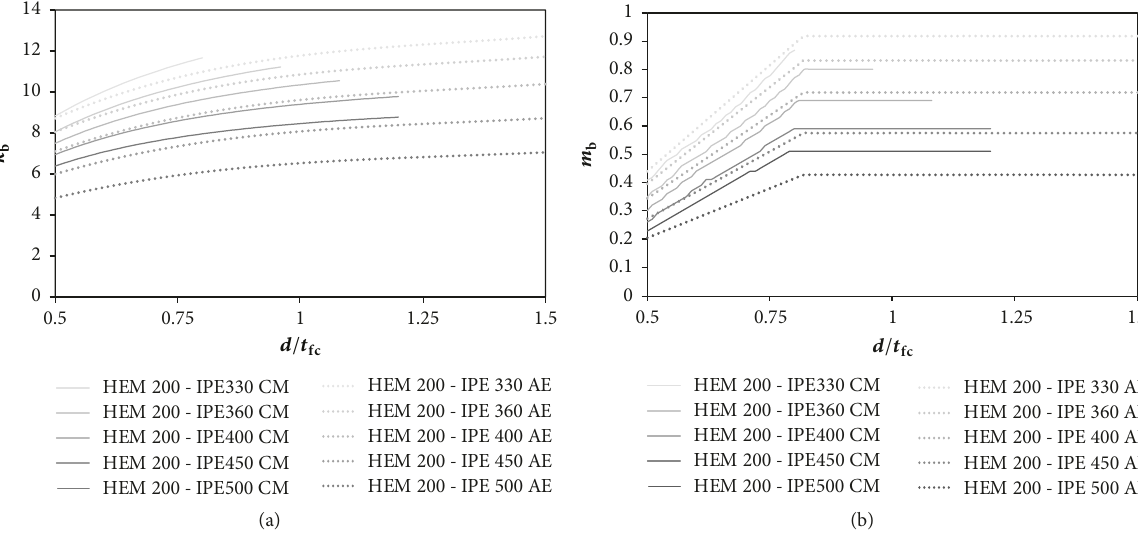
Figure11: 𝑘 b versus 𝑑/𝑡 fc (a)and 𝑚 b versus 𝑑/𝑡 fc (b)relationshipsobtainedusingboththeEC3componentmethod(CM)andtheapproximate equations (AE) for beam-to-column joints having a HEM 200 column cross section [7].